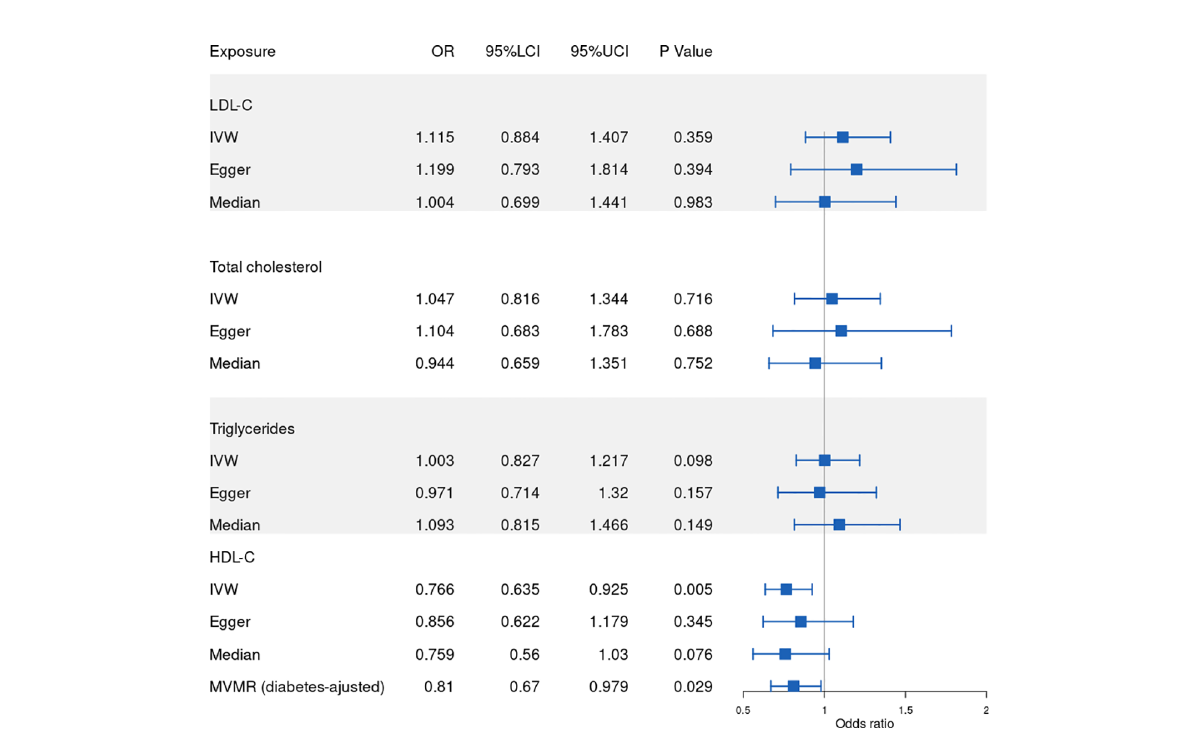
FIGURE 3 Forest plot of Mendelian randomization results from UKB. IVW: inverse variance weighted, Egger: MR – Egger, Median: weighted-median, 95% LCI: lower limit of 95% CI, 95%UCI: upper limit of 95% CI. UKB: UK